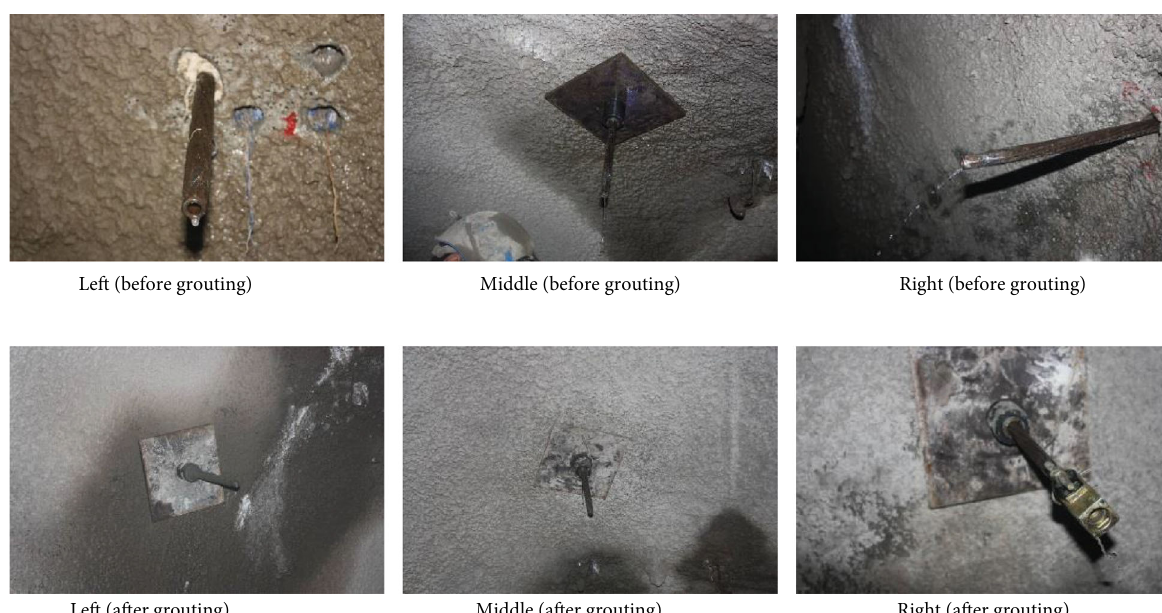
Figure 7: Comparison of water fl ow in anchor hole before and after